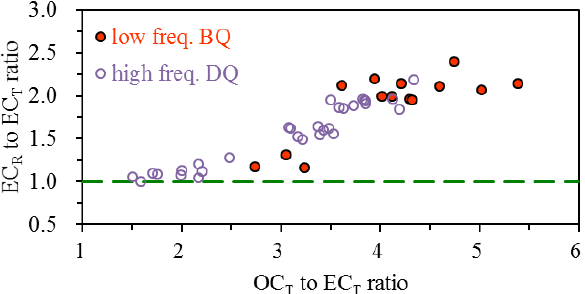
Figure 6. Dependence of the EC R to EC T ratio on the abundance of OC (estimated by the OC T to EC T ratio). The dashed line indi- cates an EC R to EC T ratio of 1.0. The EC R and EC T ratio averaged 1.91 ± 0.39 and 1.56 ± 0.36 for the low- and high-frequency sam- ples, respectively; the difference is significant at a 95% level of confidence (two-tailed p = 0 .